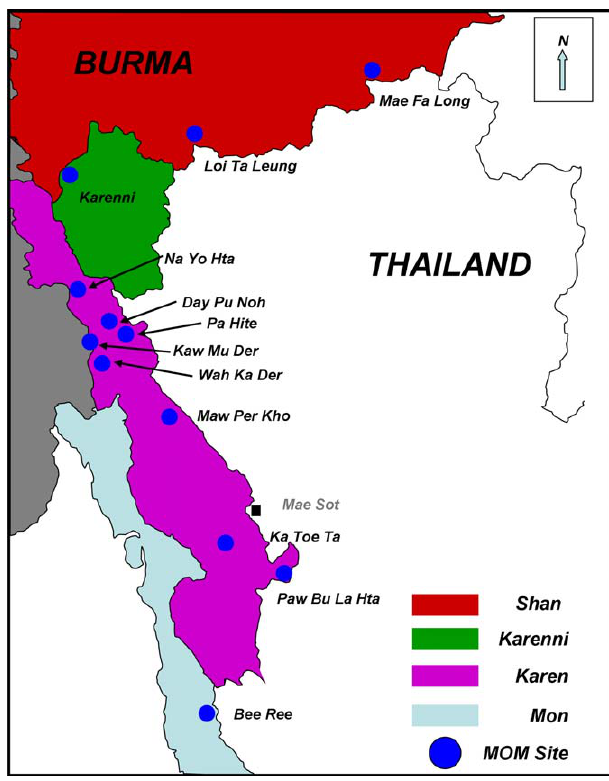
Figure 1. Location of Communities from Shan, Karenni, Karen, and Mon States Selected for Participation in the MOM Project and Included in